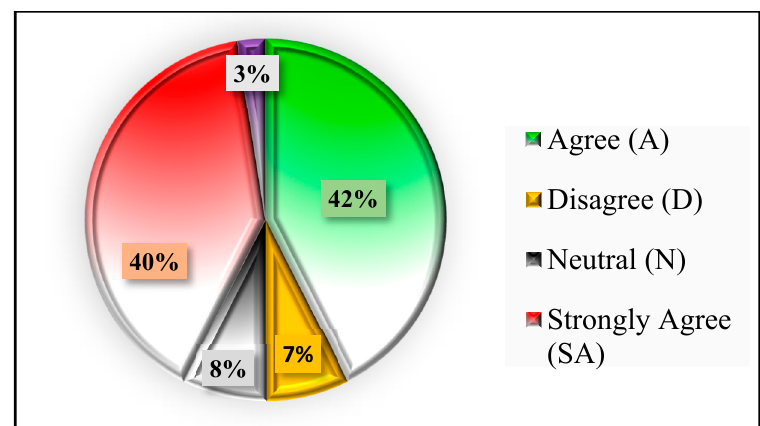
Figure 7. Vision and clarity in project management .